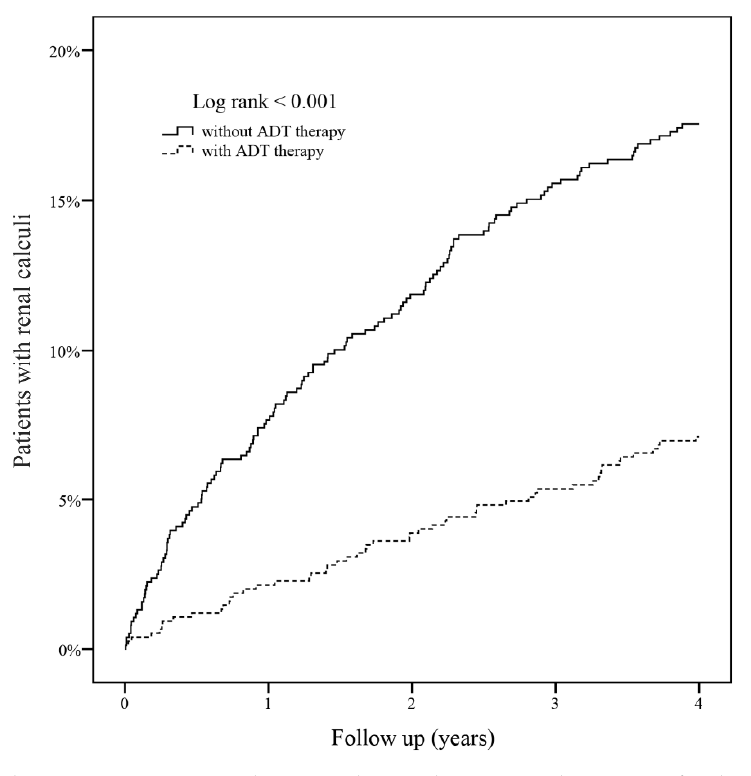
Figure 2. Kaplan–Meier curves according to androgen deprivation therapy use for the incidence of renal calculi in the propensity score–matched cohort. ADT, androgen deprivation therapy.